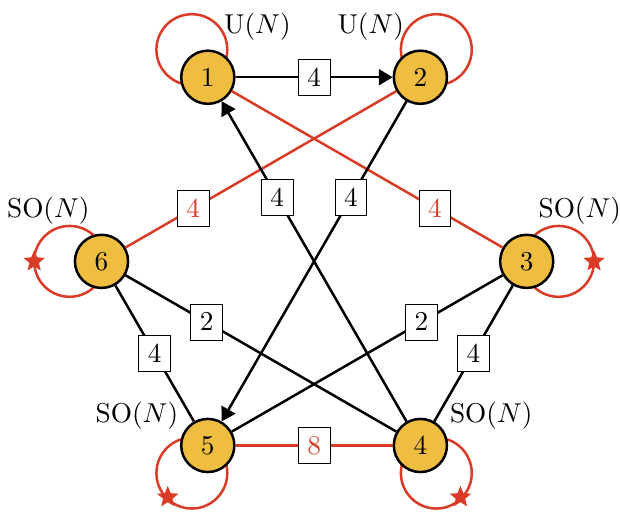
Figure 21 . Quiver diagram for the Spin(7) orientifold of phase D of Q 1 , 1 , 1 / Z 2 using the involution in eqs. (5.16), (5.17) and (5.18), together with our choice of γ